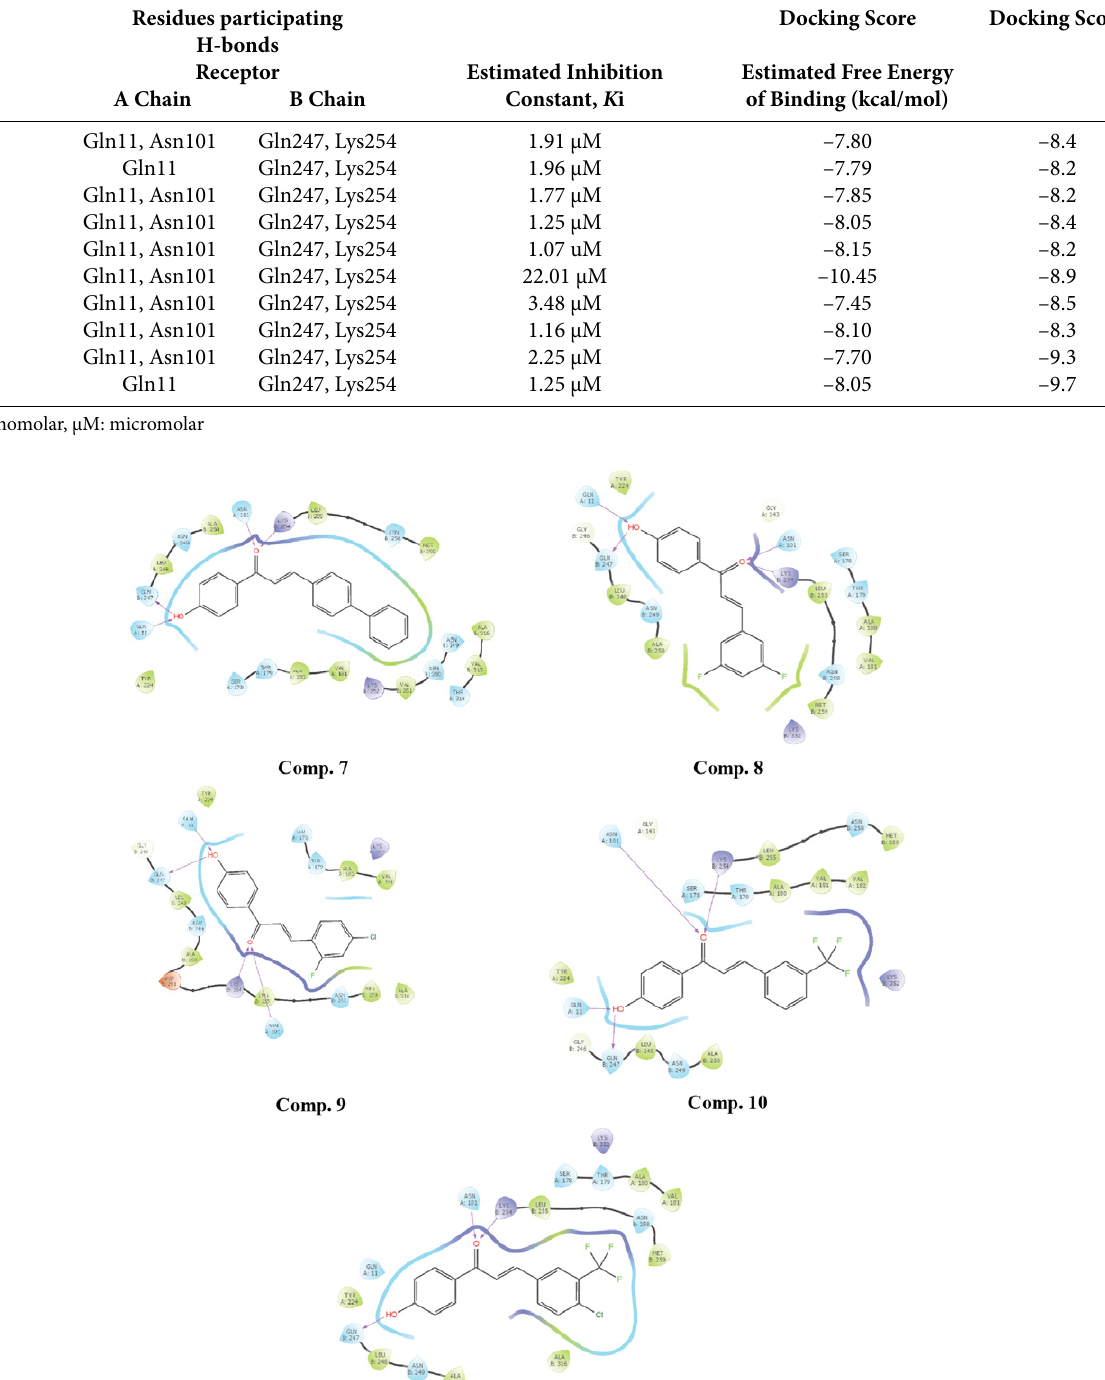
Table 4. Molecular docking binding scores of some compounds, within the tubulin-colchicine complex (PDB ID: 4O2B) active site. Residues partic- ipating in H-bonds with the compounds are shown. Comp.